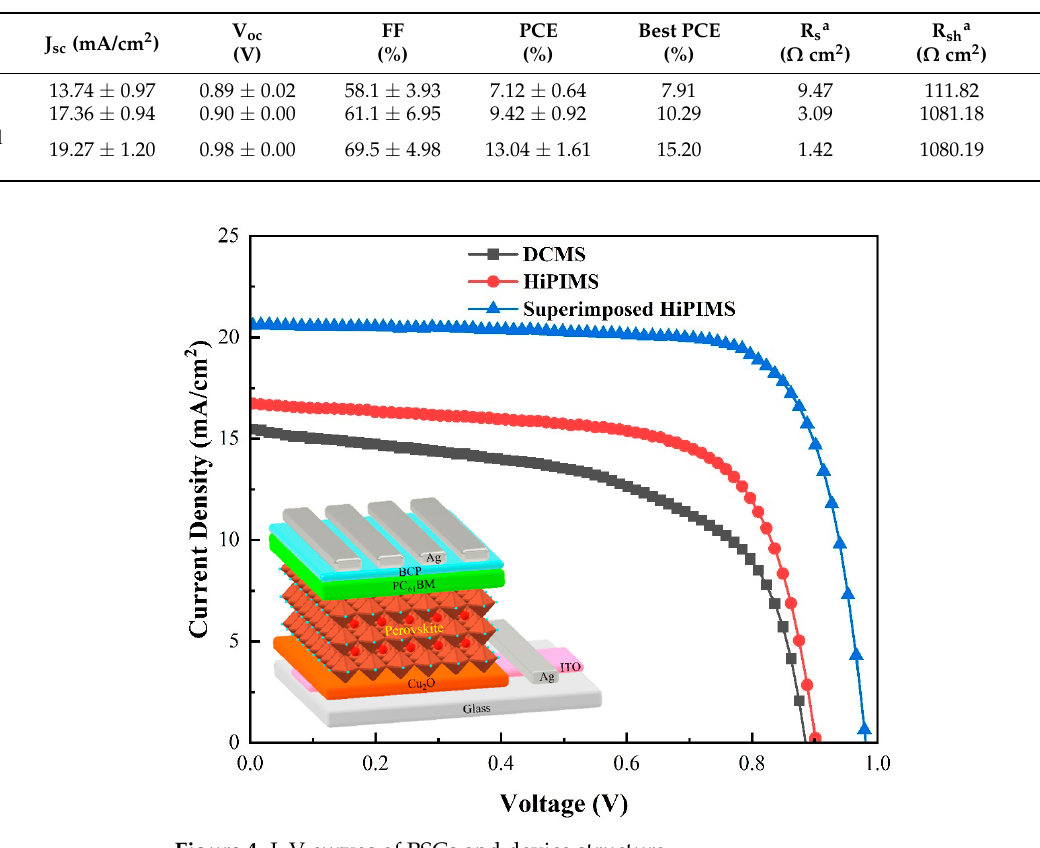
Figure 4. J–V curves of PSCs and device structure.